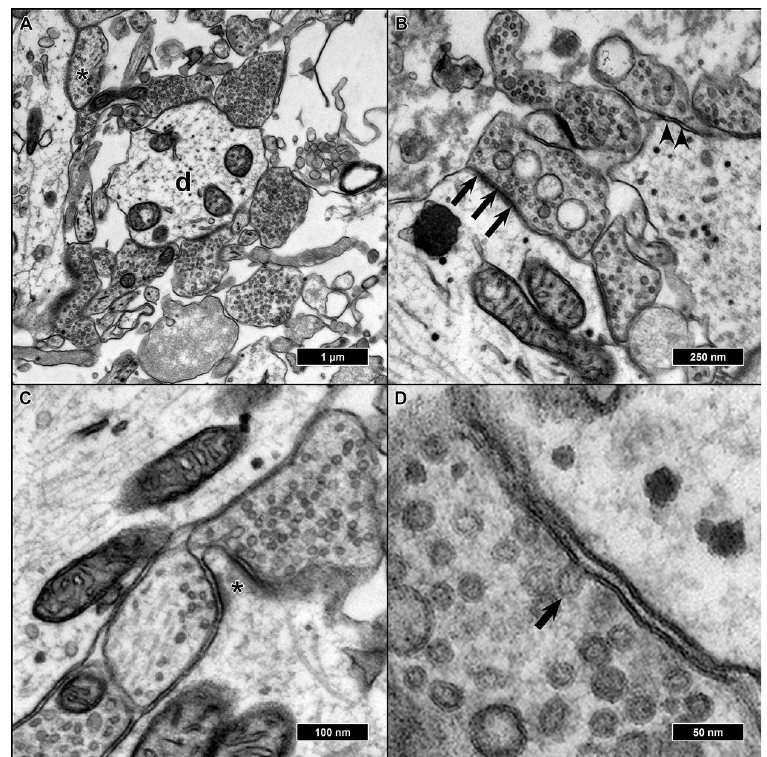
Figure 6. EM micrographs of features associated with synaptic maturity: ( A ) Synaptic boutons terminating at a dendrite (d). All entirely filled with synaptic vesicles but one (asterisk) which showed a sparser filling and thus exhibited a lesser state of maturity. ( B ) The majority of synapses were asymmetric (arrows), and some of them symmetric (arrowheads). ( C ) Protrusions resembling dendritic spines (asterisk) with surrounding synaptic boutons, but absent spine apparatus. ( D ) Synaptic bouton with a vesicle in the moment of fusion with the presynaptic membrane (arrow) as a sign of synaptic